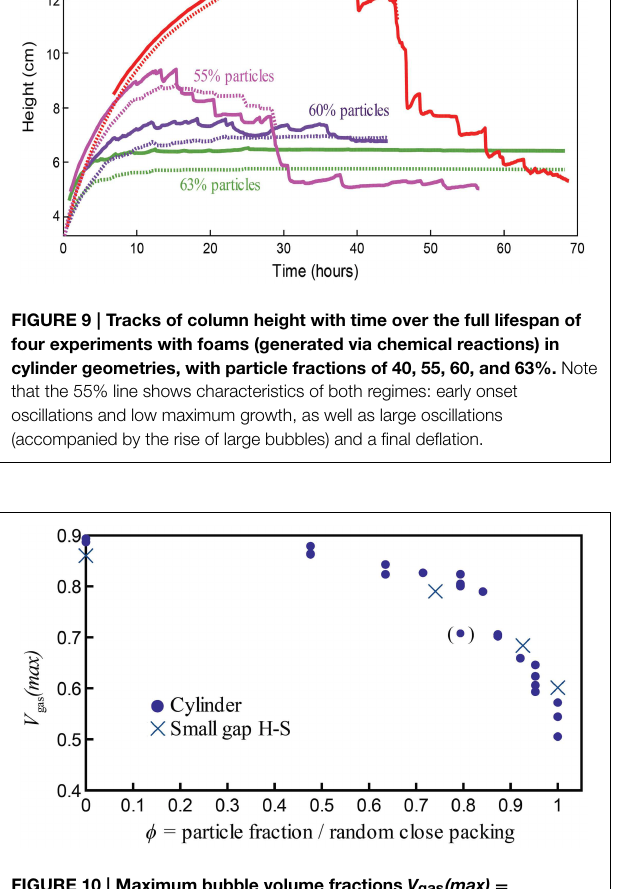
FIGURE 10 | Maximum bubble volume fractions V gas (max) = V gas /V total achieved in all experiments with bubbles generated by chemical reactions, including experiments at all temperatures tested (19–23 ◦ C). The outlier at φ = 0 . 79 is indicated in parentheses, because four additional experiments at the same φ value all reached a larger maximum bubble volume fraction of V gas /V tot ≈